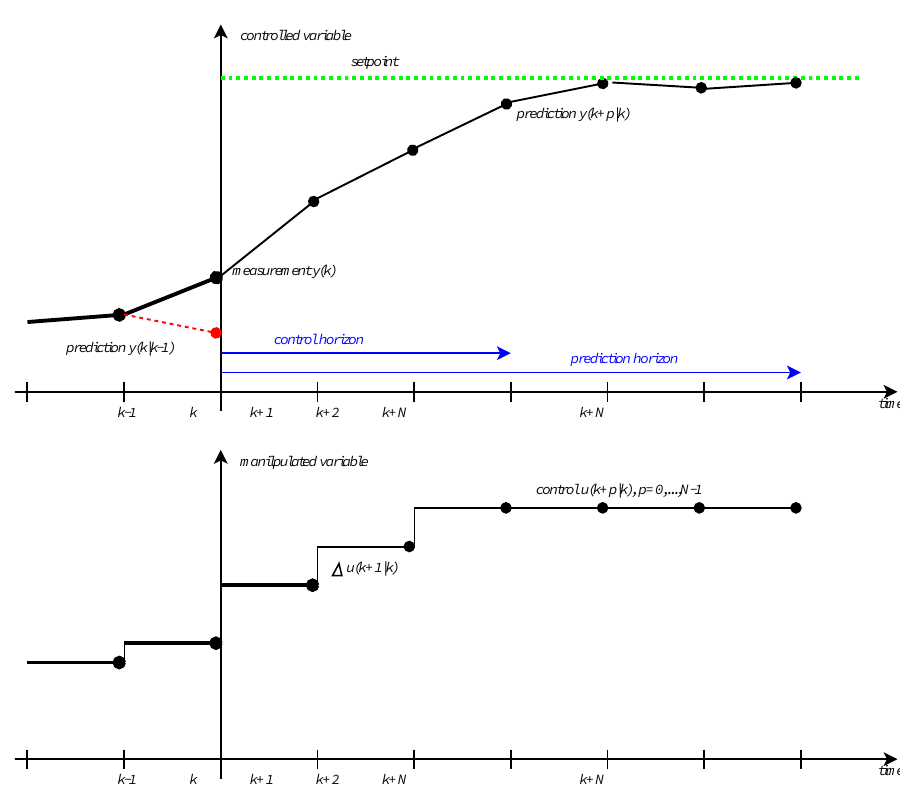
Figure 2. Receding horizon predictive control